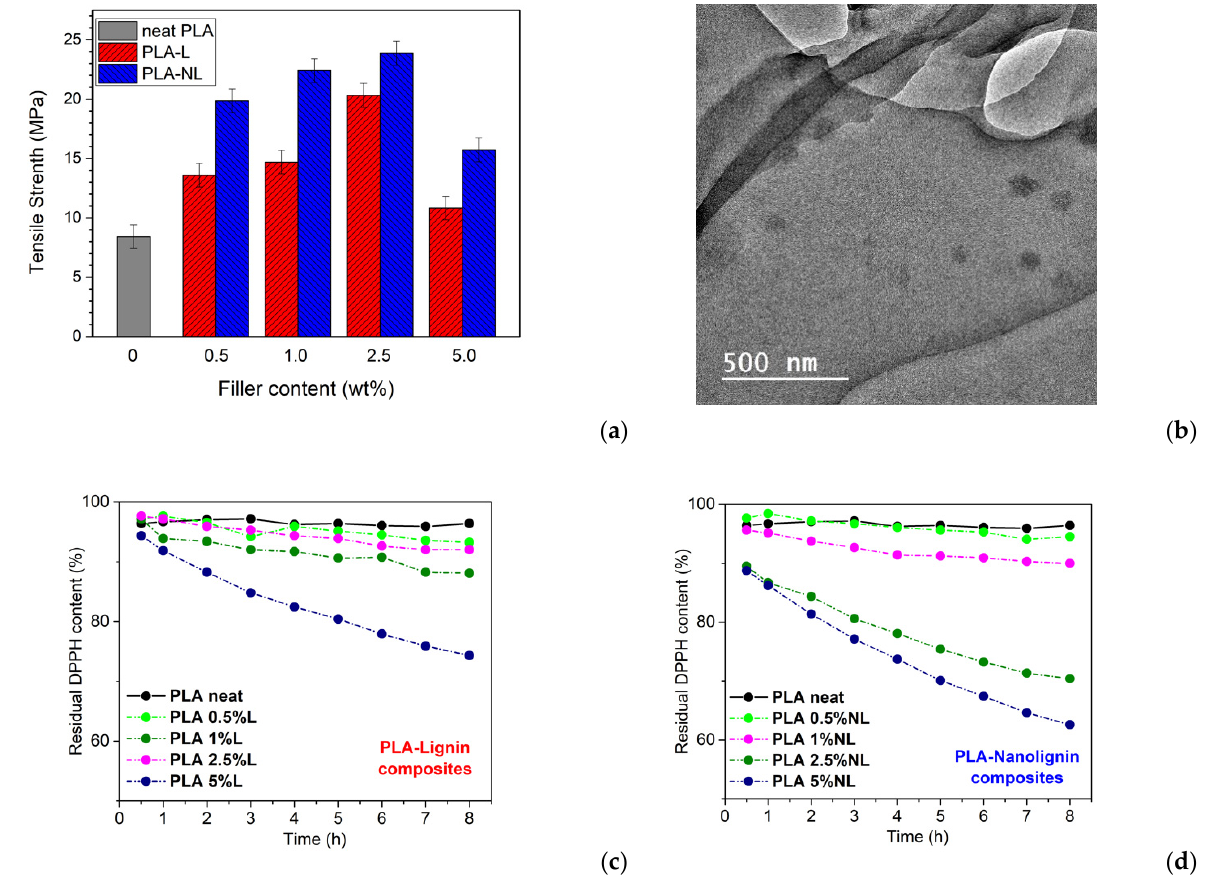
Figure 21. ( a ) Tensile strength variation pf PLA/lignin and nanolignin composites, ( b ) TEM micro- graphs of PLA/nanolignin containing 1 wt.% nanolignin and Reaction kinetics of the free radical DPPH during immersion of PLA–Lignin, ( c ) and PLA-Nanolignin ( d ) films in ethanol solution [260].